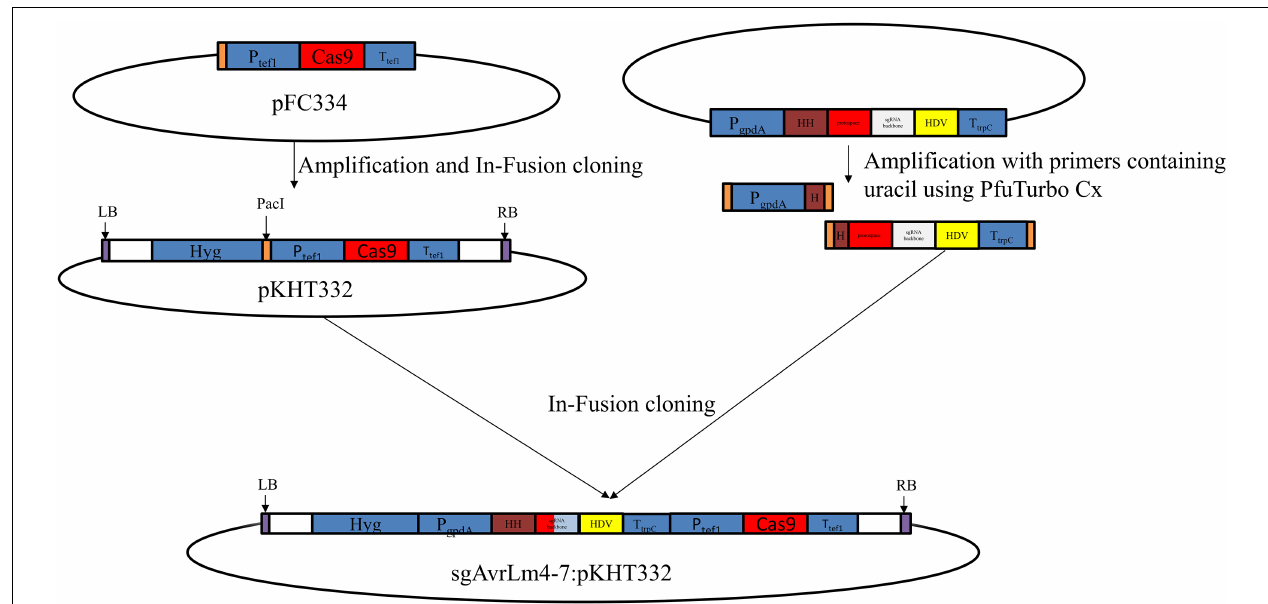
FIGURE 1 | Diagrammatic overview of the establishment of CRISPR/Cas9 mediate system in Leptosphaeria maculans AvrLm4-7 gene via in-fusion cloning strategy. Briefly, a fragment containing Aspergillus nidulans tef1 promoter, Cas9 gene, and Aspergillus nidulans tef1 terminator was amplified from a pFC334 plasmid and then inserted into pKHT332 via In-Fusion cloning. sgAvrLm4-7 :pKHT332 by inserting the AvrLm4-7 sgRNA gene together with the gdpA promoter and trpC terminator into pKHT332 (restriction enzyme cutting by Pac I) by integrating two PCR fragments amplified from plasmid pFC334 via In-Fusion cloning.